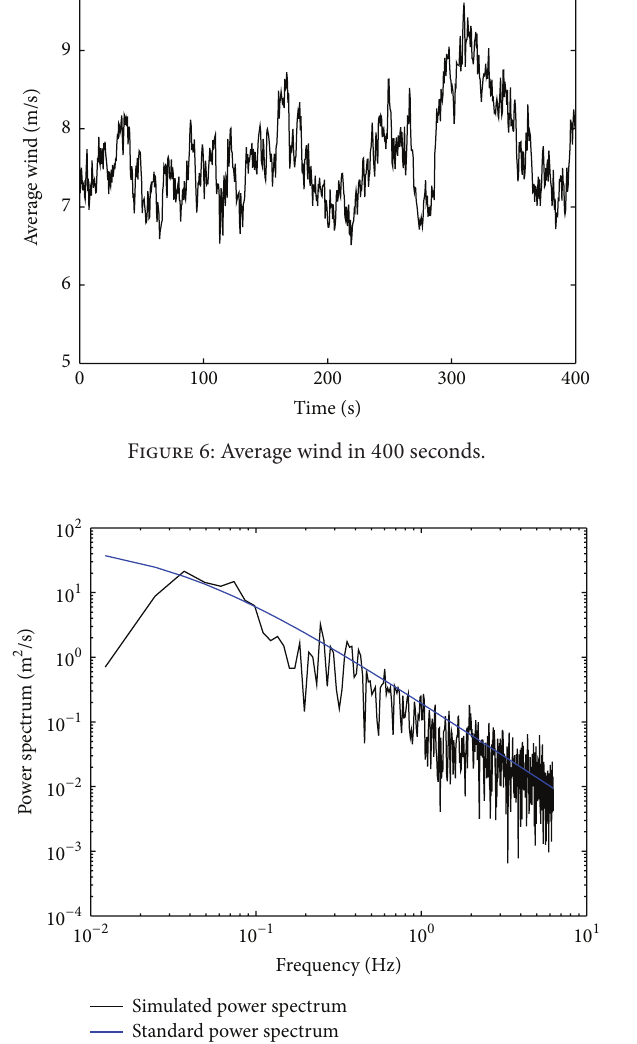
Figure 7: Simulated and standard power